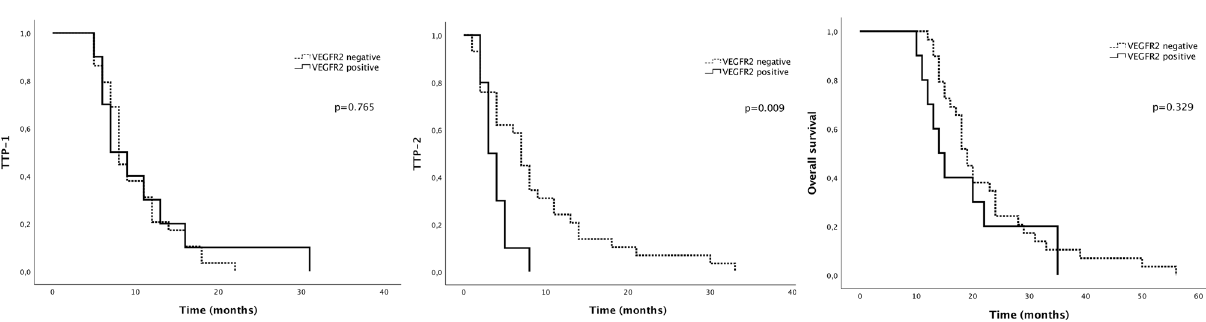
Figure 1. Kaplan–Meier analysis of survival curves according to c-Met expression.